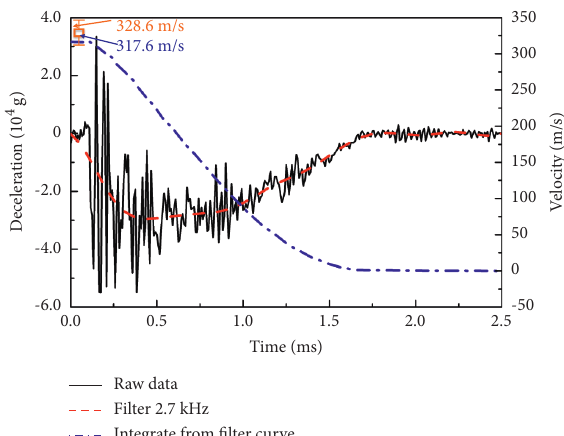
Figure 12: Curve of deceleration and velocity dependence on time for the nonproportional scaling projectile.